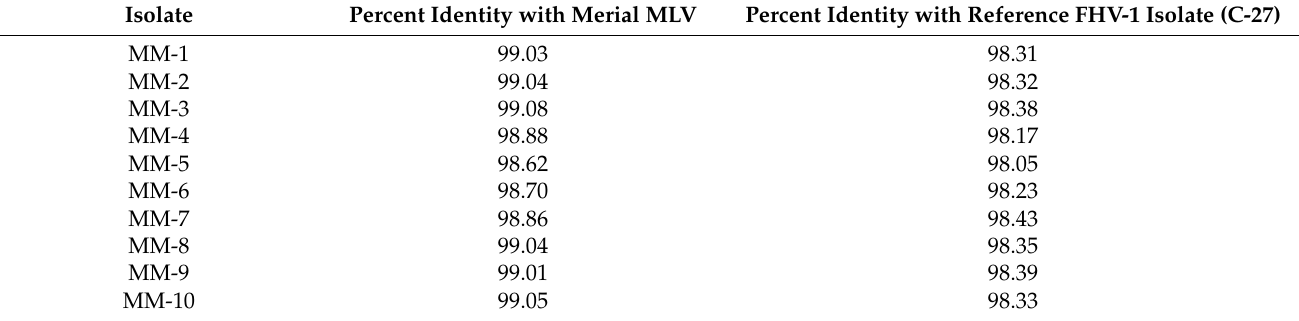
Table 4. Percent identities between each feline herpesvirus type 1 (FHV-1) strain isolated from 10 captive cheetahs and that in the Merial MLV or the reference FHV-1 isolate (C-27). In all cases, the percent identity was higher for the MLV strain than for the FHV-1 reference